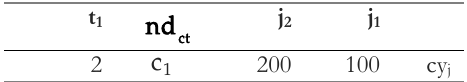
Table 1. Capacity of distribution options and consumption of goods.